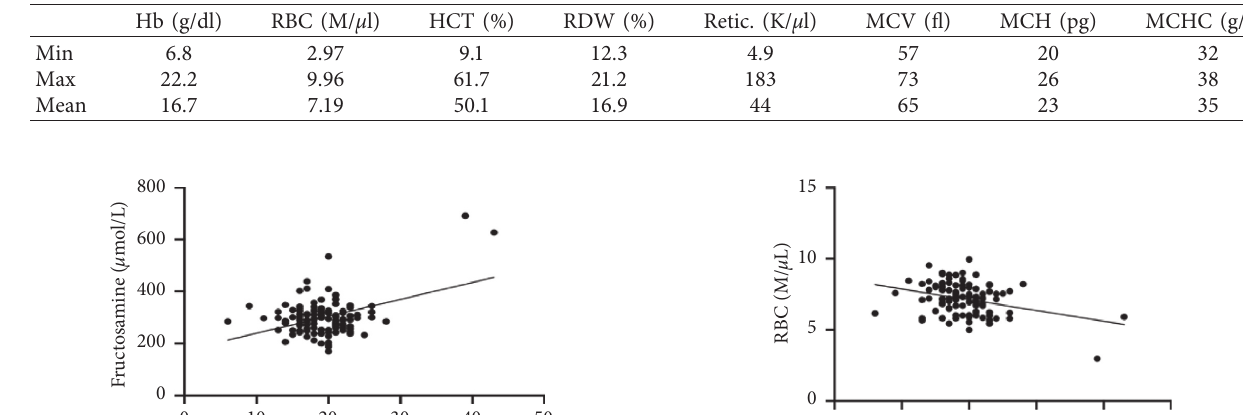
Table 1: Descriptive statistics of the hematological analytes.